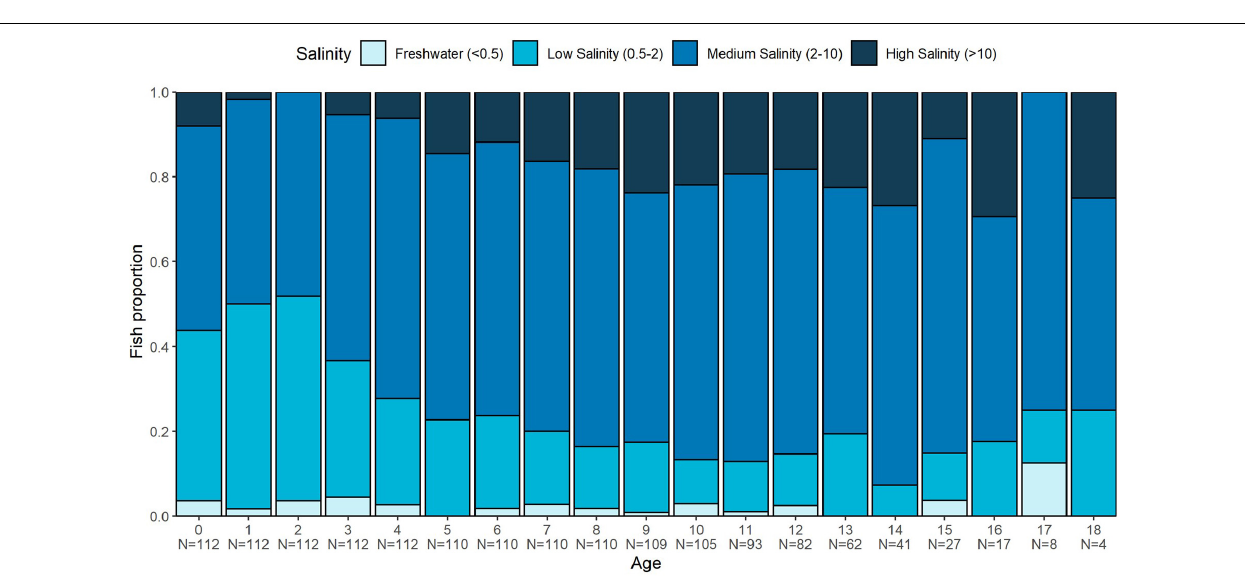
White Sturgeon over their lifespan prior to capture.